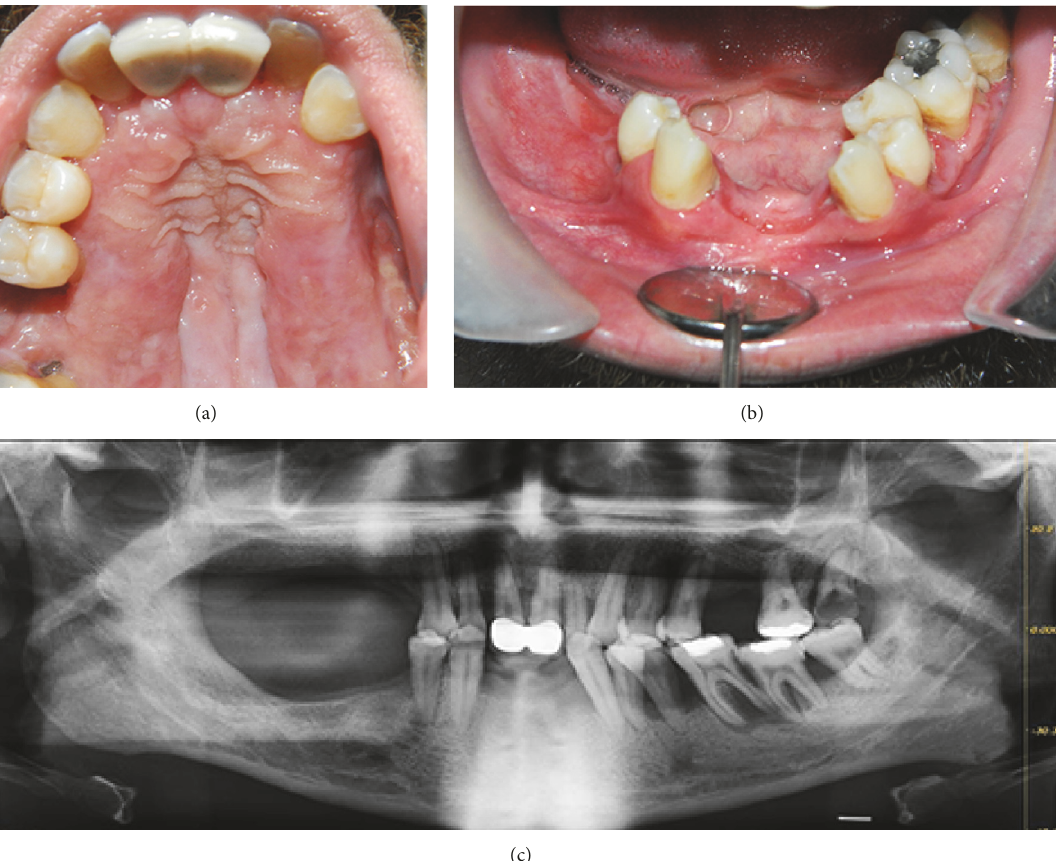
Figure 3: (a) Intraoral view of the patient 12 months after initiation of chemotherapy. Significant regression of gingival lesions is observed on the palatal surface of the maxilla. (b) Intraoral view of the patient 12 months after initiation of chemotherapy. Significant regression of gingival lesions is observed in the mandible. (c) Panoramic radiograph of the patient 12 months after initiation of chemotherapy. Periradicular bone levels of the remaining teeth are maintained except for mandibular left premolar and molar teeth, around which minimal progression of the alveolar bone loss is